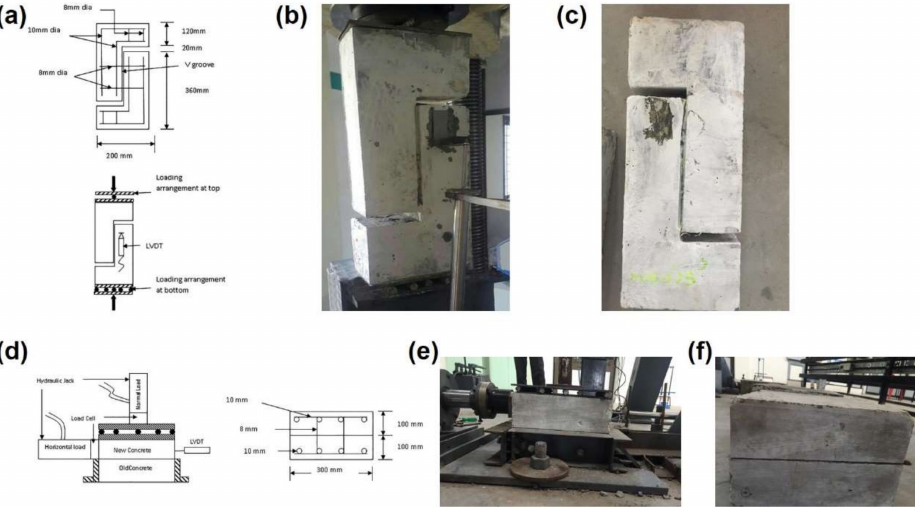
Figure 7. Schematic diagrams and photos of push-off test (( a – c ): conventional push-off test; ( d – f ): modified push-off test. ( b ) and ( e ) before test, ( c ) and ( f ) after test)